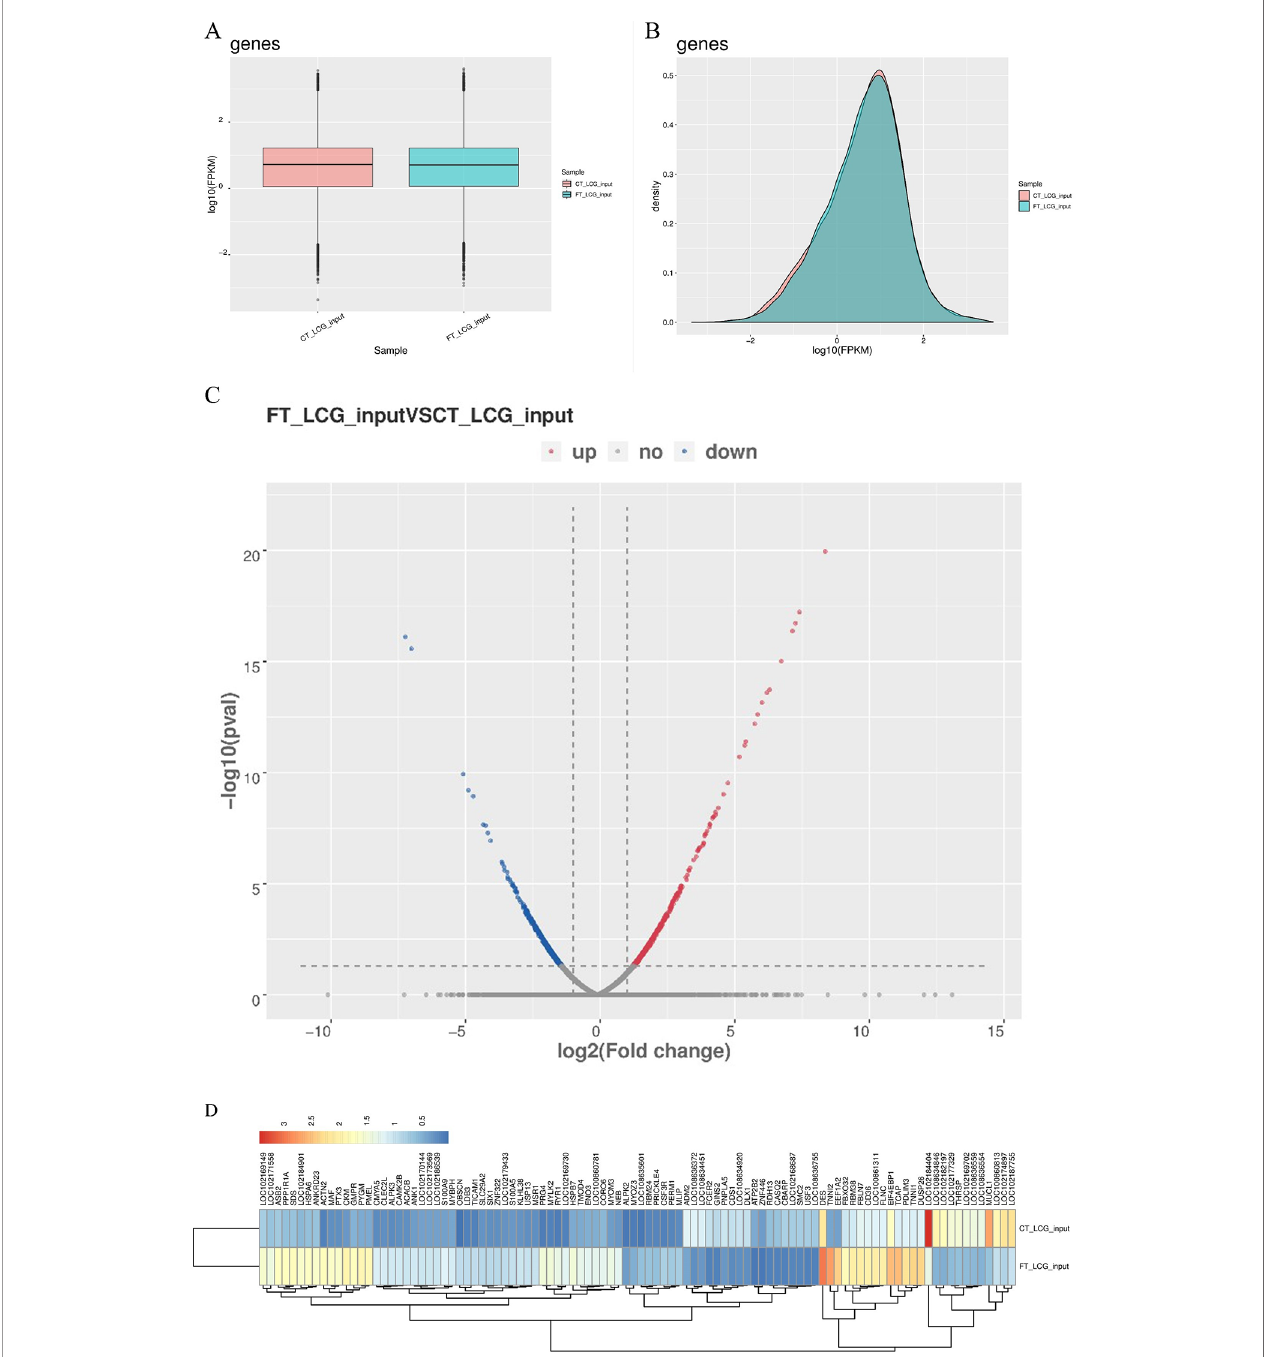
FIGURE 4 | Overview of differentially expressed genes in goats skin samples. (A) Gene expression box plot. (B) Gene expression density map. (C) Volcanic map of differentially expressed genes. [log2(fold change) was used as the horizontal coordinate, and -log10( p -value) was used as the vertical coordinate. Volcanic map was drawn for all genes in the differentially expressed analysis. The abscissa represents the multiple change of gene expression in different samples. The ordinate represents the statistical signi fi cance of differences in gene expression level. Red represents signi fi cantly differentially expressed genes up-regulated, blue represents signi fi cantly differentially expressed genes down-regulated, and gray dots represent non-signi fi cantly differentially expressed genes.] (D) Heatmap of the genes of FT- LCG and